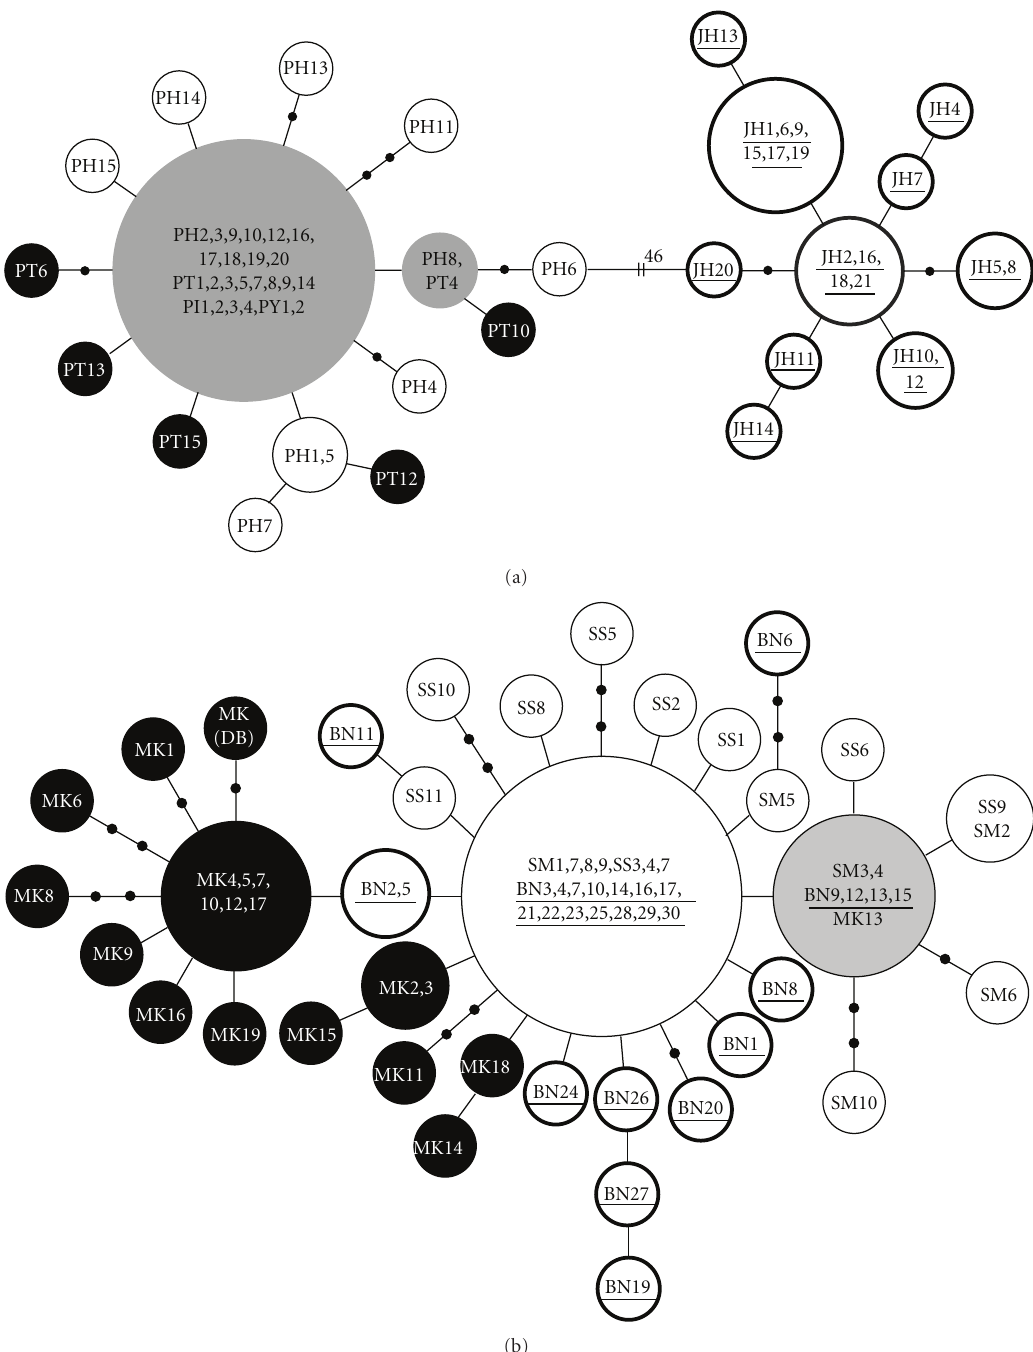
Figure 4: The minimum spanning trees revealing the genetic population structure based on the 423-bp mitochondrial ND4 sequences. The tree (a) was constructed using total 60 specimens of B. platifrons from the seeps of the Sagami Bay (PH1 ∼ 20), B. platifrons from the vents of the Okinawa Trough (PT1 ∼ 10, 12 ∼ 15, PI1 ∼ 4, PY1, 2), and B. japonicus from the seeps of the Sagami Bay (JH1, 2, 4 ∼ 21). Black, haplotypes possessed by B. platifrons specimens from the vents; gray, haplotypes shared by B. platifrons specimens from the seeps and vents; white, haplotypes possessed by B. platifrons or B. japonicus specimens from the seeps. The tree (b) was constructed using a total of 70 specimens of B. septemdierum from the Myojin Knoll (SM1 ∼ 10) and the Suiyo Seamount (SS1 ∼ 11) , B. brevior from the North Fiji Basin (BN1 ∼ 17, 19 ∼ 30), and B. marisindicus from the Kairei field (MK1 ∼ 19, MK from a database). Black, haplotypes possessed by B. marisindicus specimens; gray, haplotypes shared by the three species; white with the bold outline, haplotypes possessed by B. brevior ; white with the thin outline, haplotypes possessed by B. septemdierum or those shared by B. brevior and B.